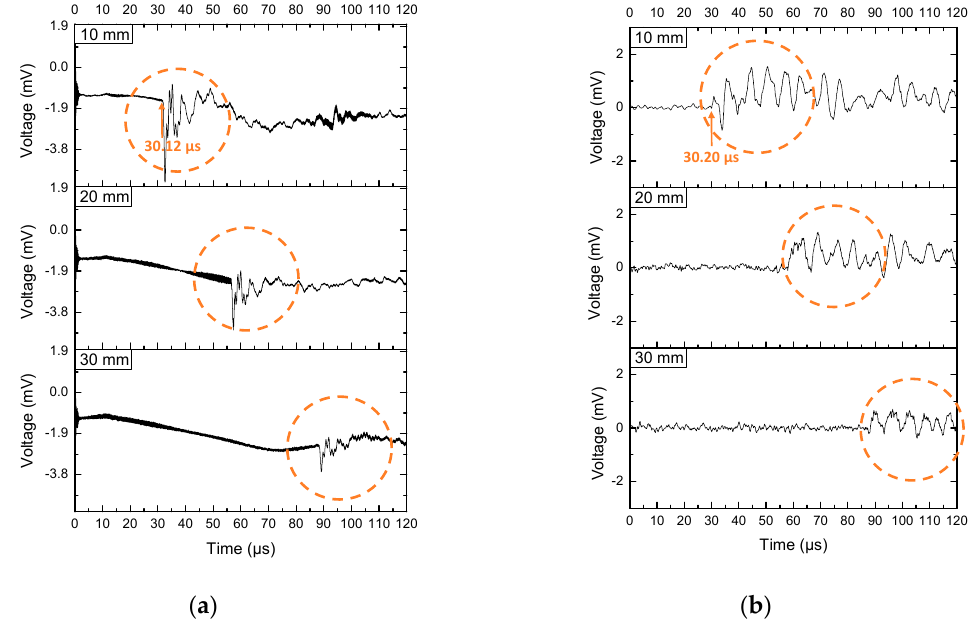
Figure 6. The ultrasonic signal detected by the ( a ) microphone and ( b ) FP fiber sensor.